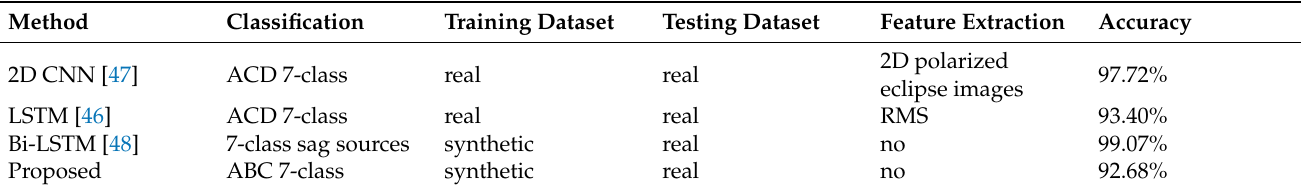
Table 9. Overview of a selection of similar